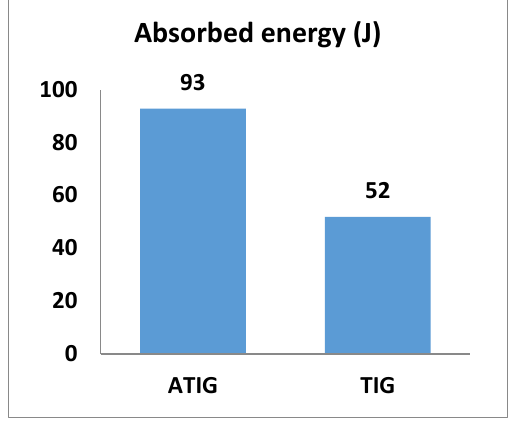
Figure 15. Impact test results of ATIG and TIG in HAZ.